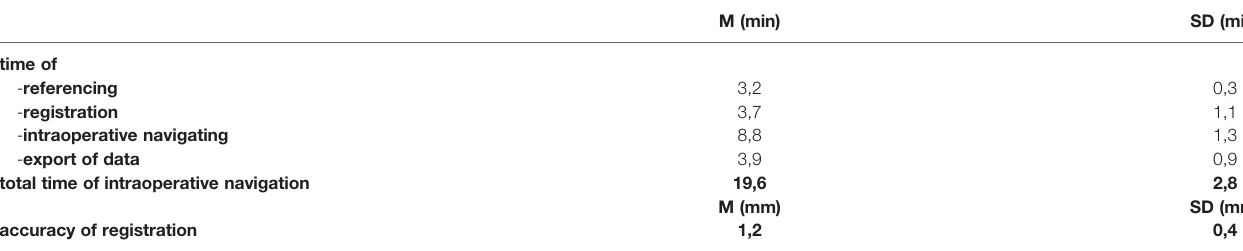
Bold values are the main